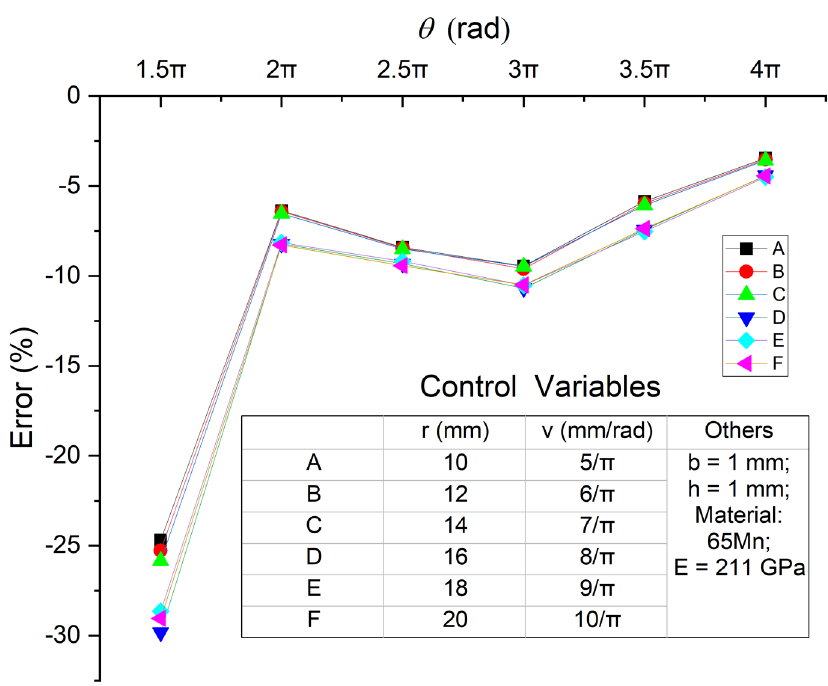
Figure 6. Errors between twice calculated stiffness and stiffness from FEA of double-arm planar spiral